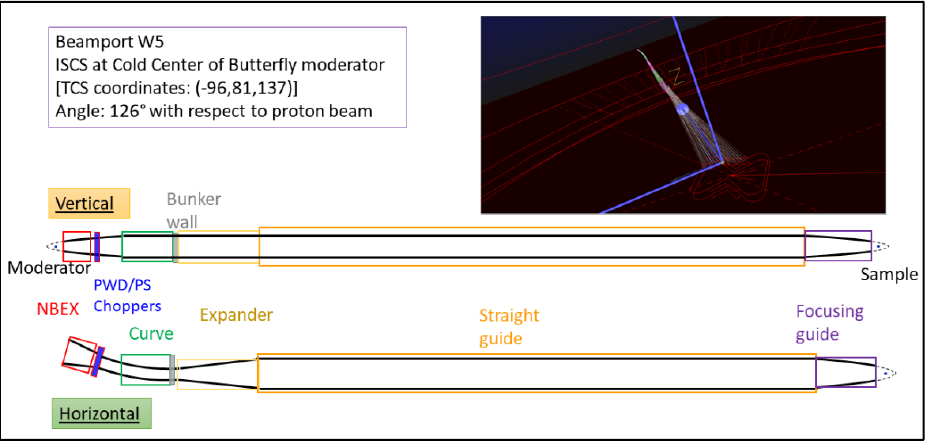
Figure 1. Vertical and horizontal layouts for the preliminary concept of the MIRACLES primary spectrometer. Inset: McStas illustration of the instrument source coordinate system, which is located at the west corner of the cold source of the ESS butterfly moderator.